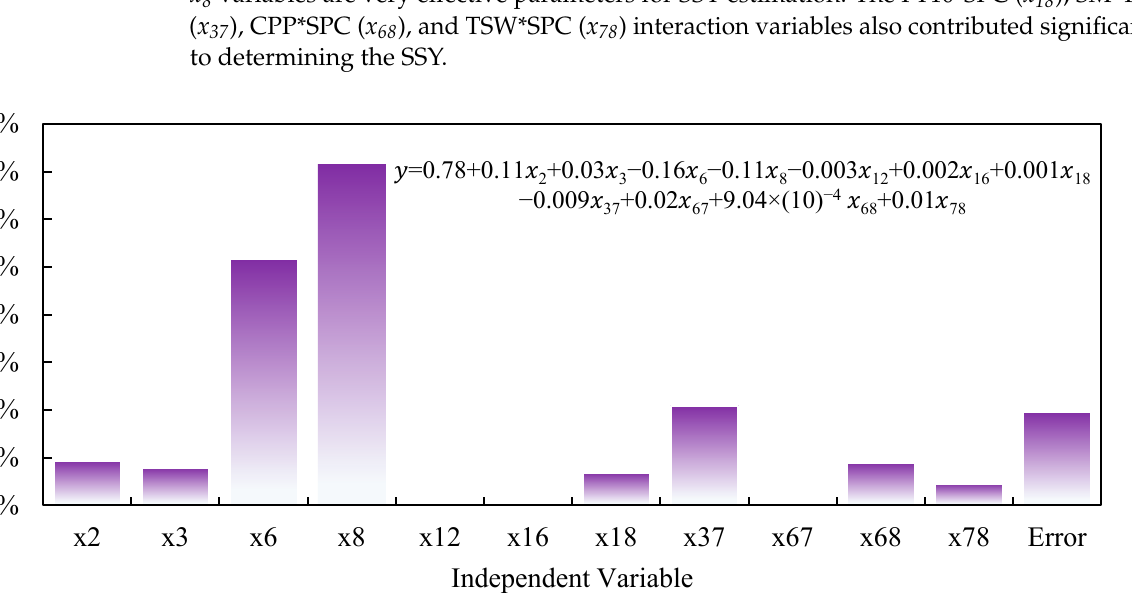
−0.003 (cid:1876) 8